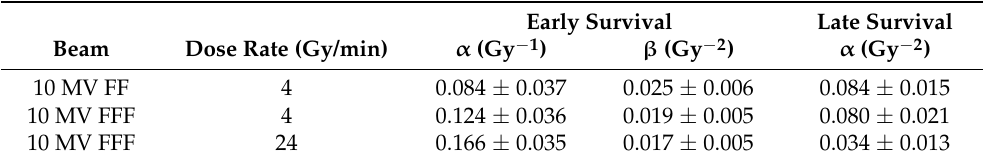
Figure 1. Dose–response curves for early and late survival of Chinese hamster V79 cells irradiated with 4 Gy/min-FFF (solid circle), 4 Gy/min-FF (open circle), 24 Gy/min-FFF (solid triangle): early survival (panel ( A )), late survival (panel ( B )). The error bar represents the standard error of the mean (SEM) coming from 3 independent experiments for each irradiation condition used. Table 1. Parameters of the dose–response curves for the early and late survival of V79 cells irradiated with 10 MV photons in the different beam configurations.